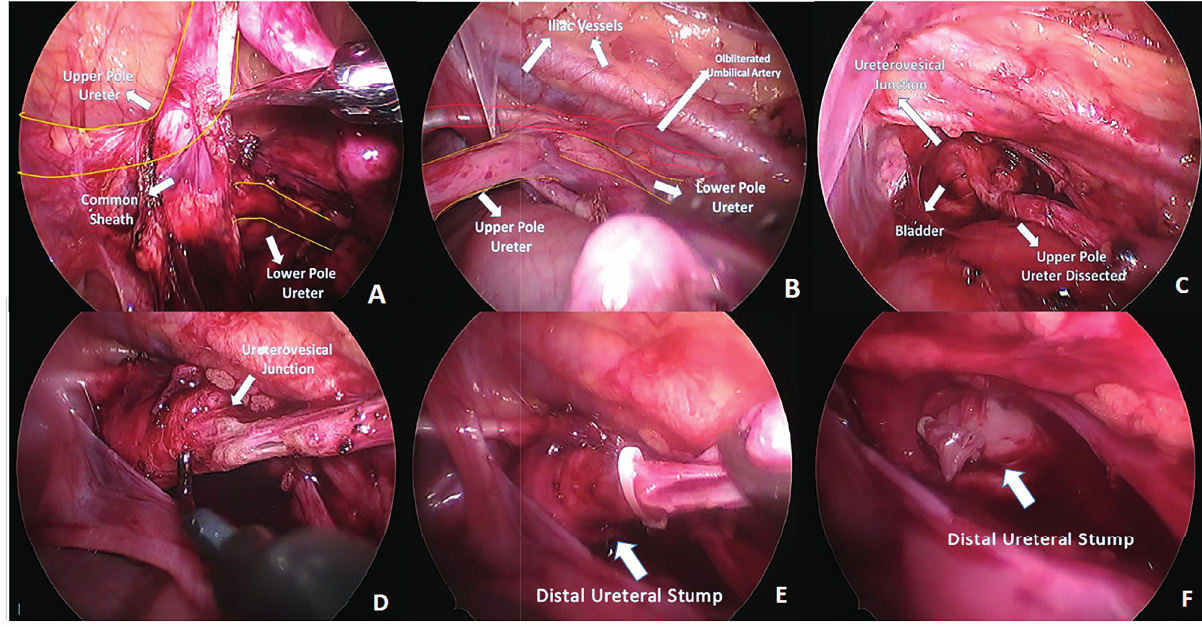
Figure 1 - Laparoscopic dissection of distal ureter in a 4 years-old girl with duplex kidney with non-functioning refl ux upper